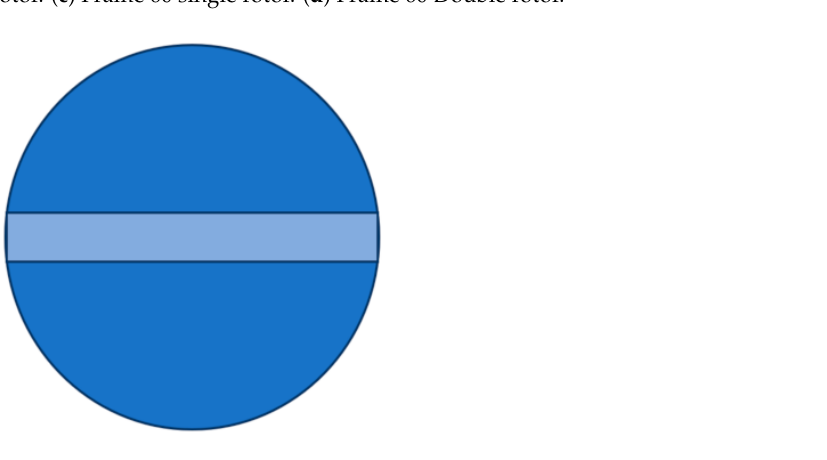
Figure 10. Highlighted area showing cross-section of the crusher sampled to obtain average